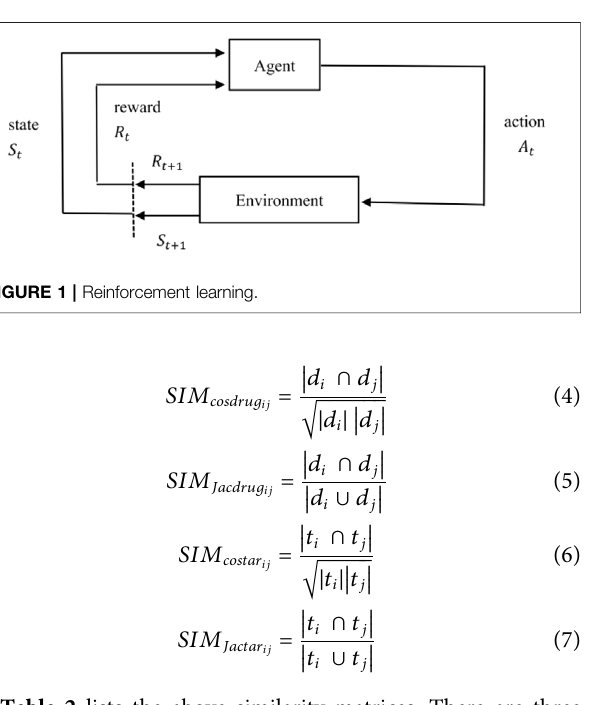
Table 2 lists the above similarity matrices. There are three similarity matrices in the drug space and the target space respectively.